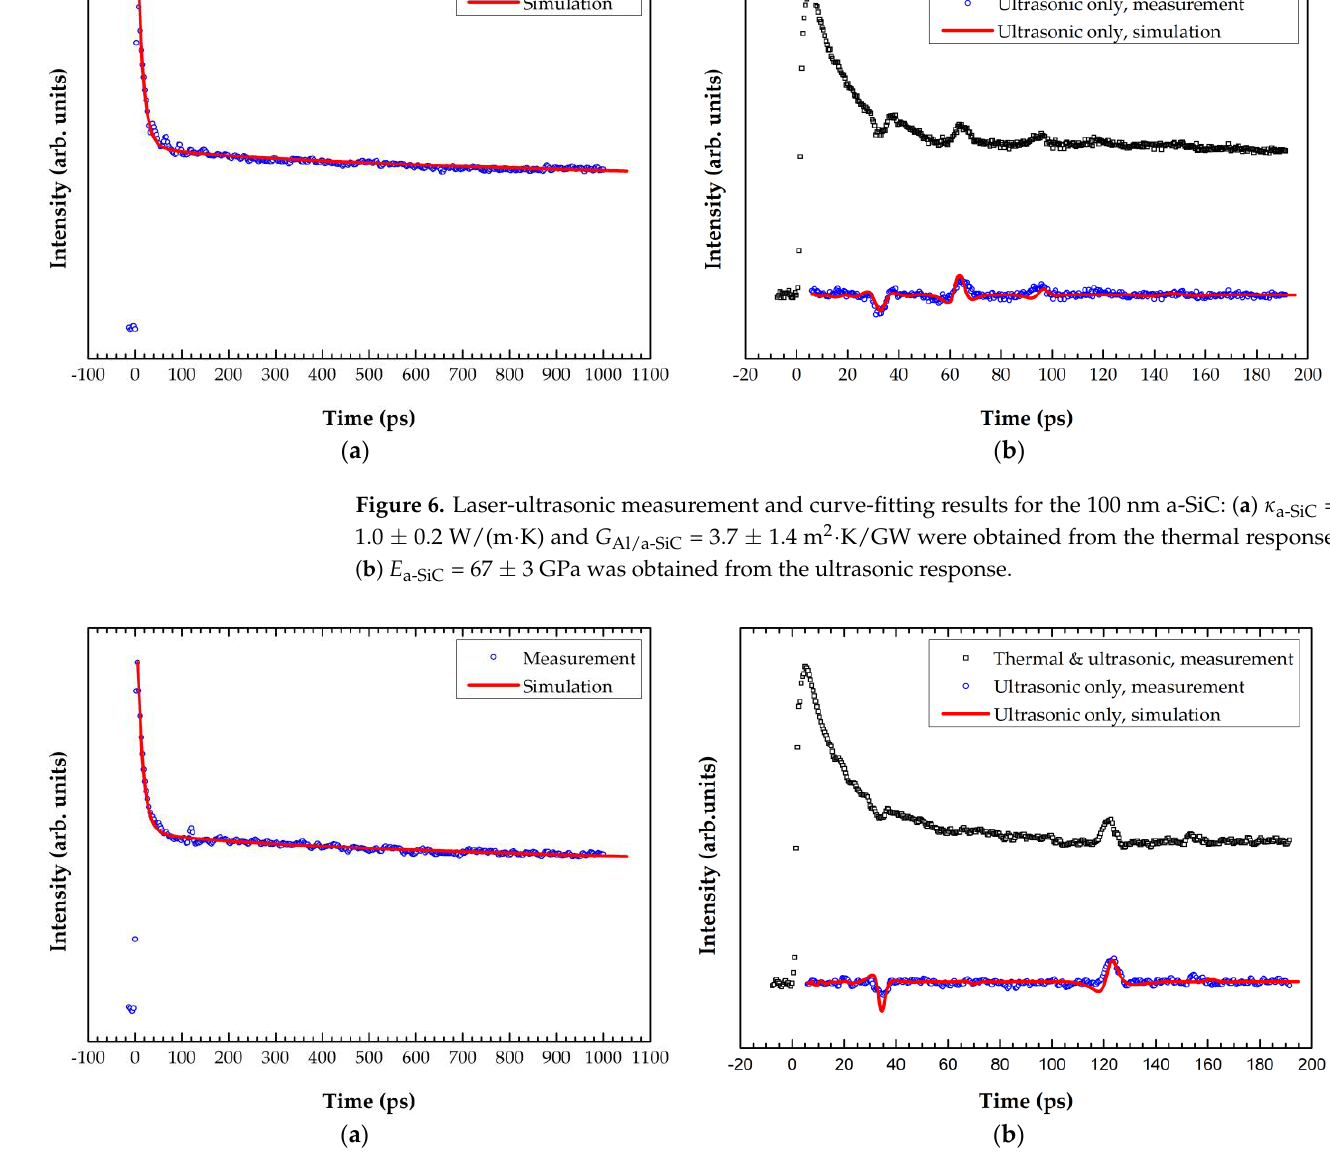
Figure 7. Laser-ultrasonic measurement and curve-fitting results for the 300 nm a-SiC film: ( a ) κ a-SiC = 1.1 ± 0.2 W/(m·K) and G Al/a-SiC = 5.5 ± 1.6 m 2 ·K/GW were obtained from the thermal response; ( b ) E a-SiC = 76 ± 3 GPa was obtained from the ultrasonic response.